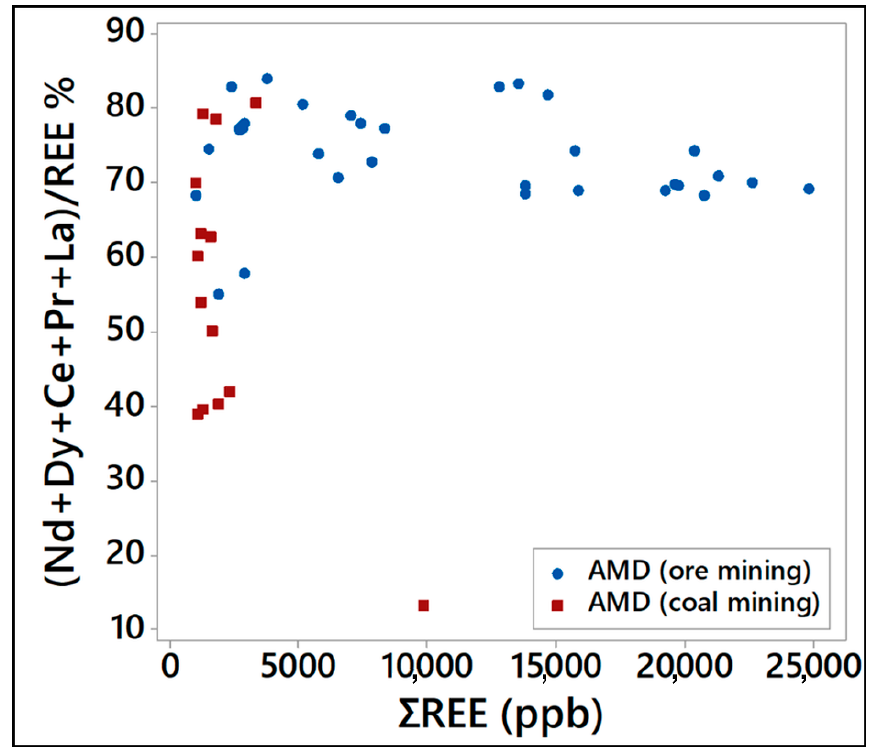
Figure 8. Percentage of critical elements for the market of electromobility vs. Σ REE for acid mine drainage discharges from coal and ore mining with a total REE content >1000 ppb.